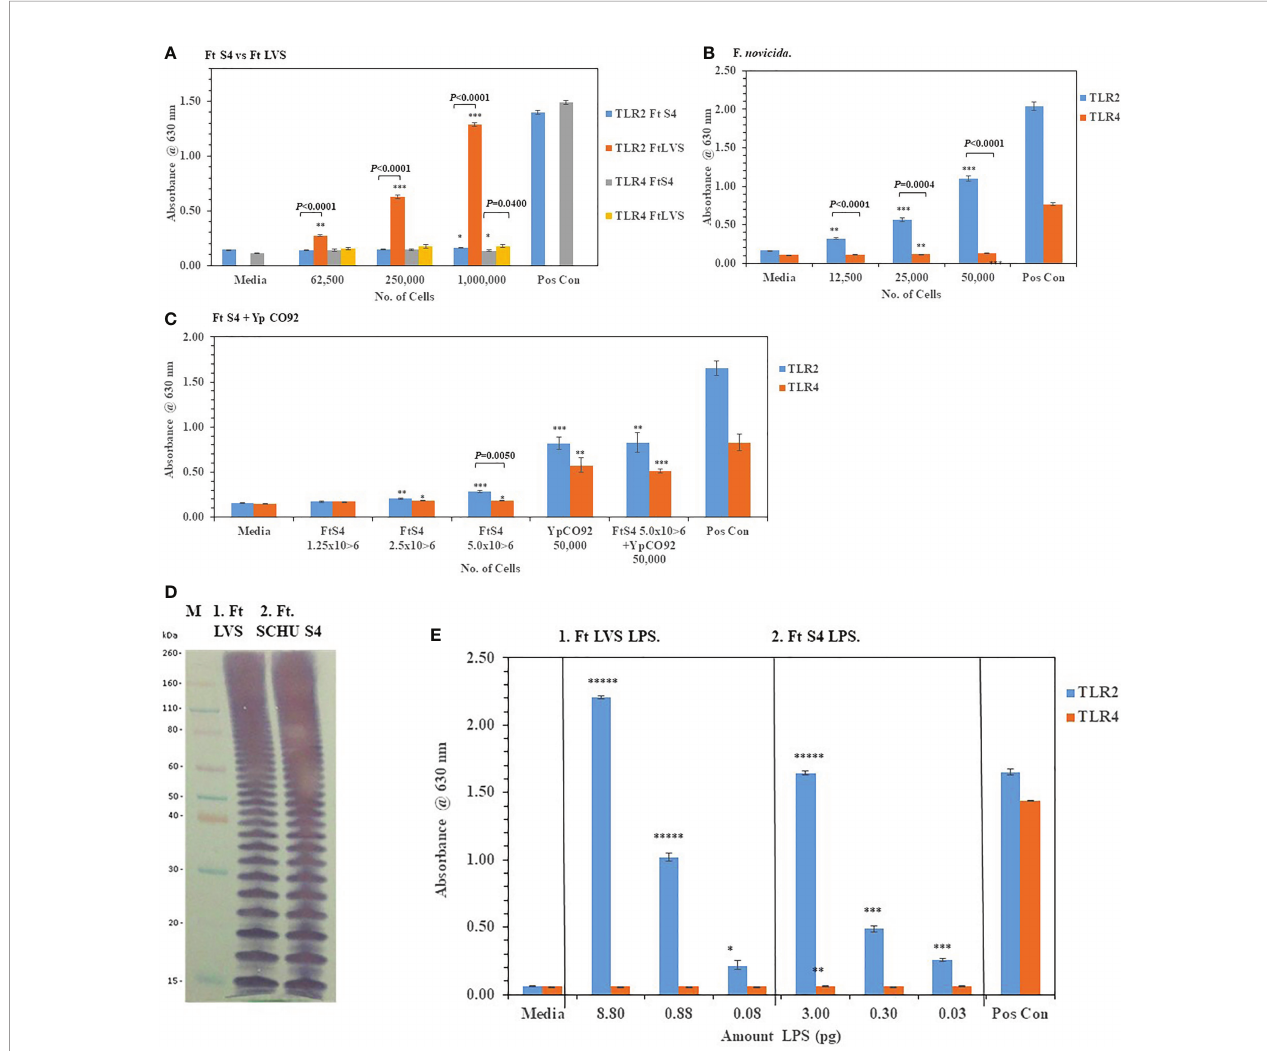
FIGURE 6 | F. tularensis Schu S4 mitigates the activation of TLR2 and TLR4. Bacterial cell suspensions of F. tularensis ( Ft ) Schu S4, Ft LVS, and F. novicida were prepared from colonies in PBS after ~72 h of growth at 37°C on chocolate agar plates, and diluted bacterial cells were used to inoculate HEK293-TLR2 or -TLR4 cells. After 18 − 20 h of incubation, the amount of TLR2 and TLR4 activation was determined. (A) The activation of TLR2 or TLR4 by increasing amounts of Ft Schu S4 and Ft LVS was examined. (B) The activation of TLR2 or TLR4 by increasing amounts of F. novicida was examined. (C) The activation of TLR2 or TLR4 by increasing amounts of Ft Schu S4 was examined with and without Y. pestis ( Yp ) CO92 that was grown at 28°C on SBA plates for ~ 45 h. (D) Western blot (WB) analysis (10% Tricine gel) of LPS extracts from Ft Schu S4 (7 µl), lane 1, and Ft LVS (7 µl), lane 2. Note the numerous bands in both LPS preparations that may re fl ect the longer chain length of the O-antigen polysaccharide compared to other bacteria (see Figure 5D ). (E) Activation of TLR2 and TLR4 by Ft Schu S4 (panel 1) or Ft LVS (panel 2) LPS extracts. All samples were analyzed in triplicate, and results represent one of two independent repeats. Results of TLR activation are presented as geometric mean with standard error of the mean. The media control was PBS, and positive controls (Pos Con) were HKLM (2 x 10 6 cells) for TLR2, and E. coli LPS (0.2 ng) for TLR4. Signi fi cant differences in activation between cells are shown above the results. Signi fi cant values compared to media control are shown: * P ≤ 0.05; ** P ≤ 0.01; *** P ≤ 0.001; **** P ≤ 0.0001; ***** P ≤